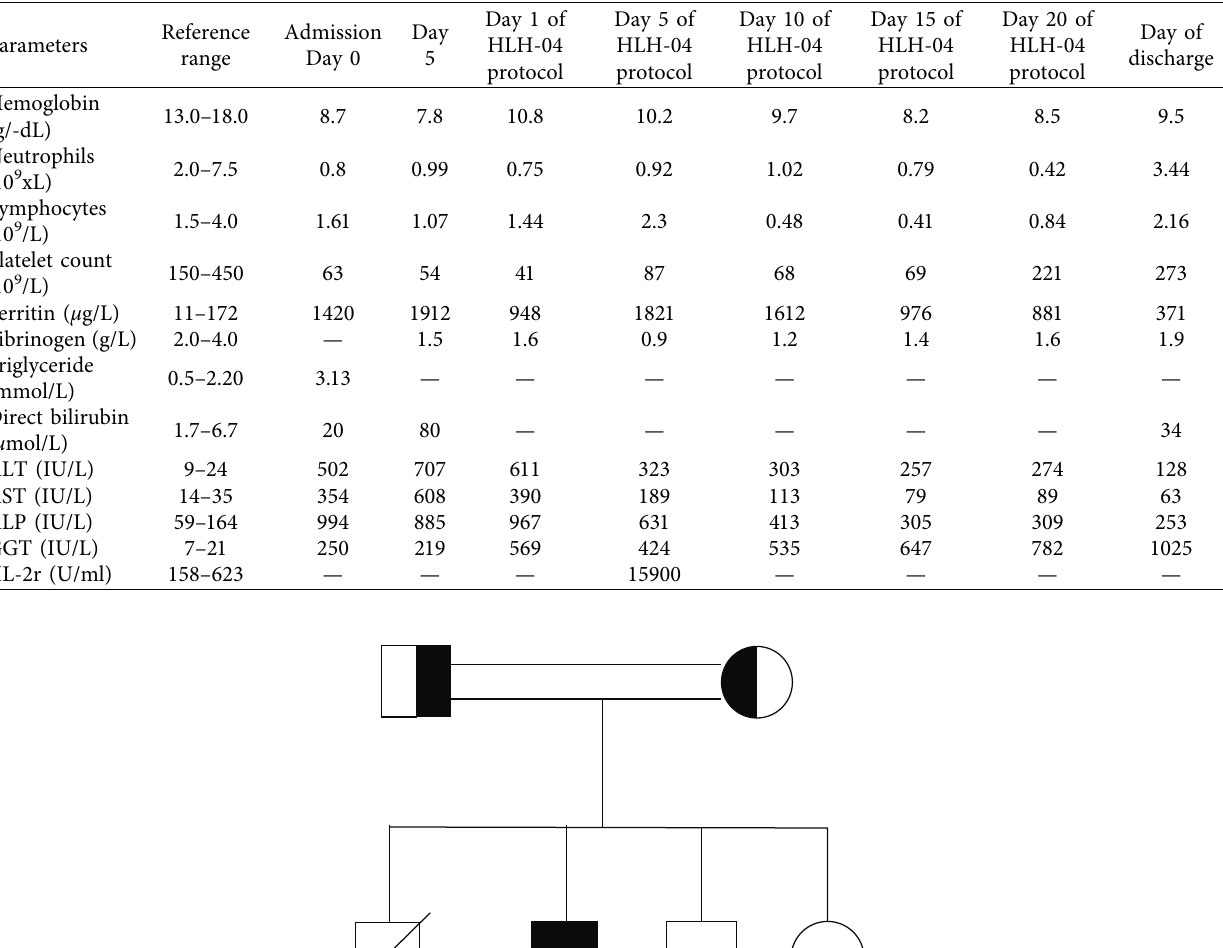
Table 1: An overview of relevant laboratory parameters during the clinical course of the patient. Parameters